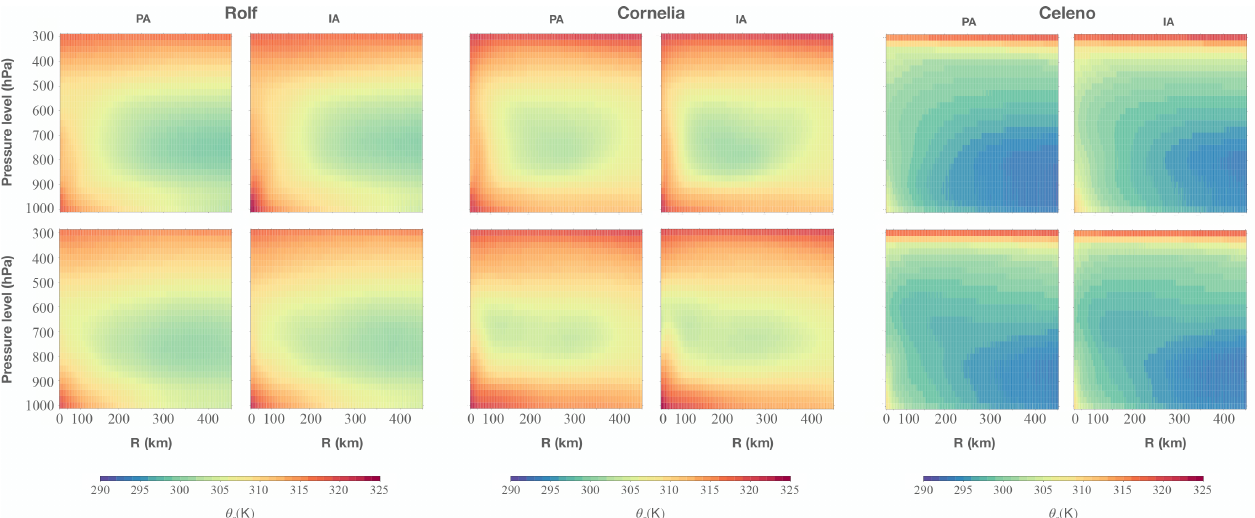
Figure 4. Time-averaged height–radius cross sections of the equivalent potential temperature ( θ e ) over all time steps in which a medicane is found in the NN (top) and SN (bottom) simulations for medicanes Rolf (simulation starting 5 November 2011 at 00:00UTC with 36h of run-up time), Cornelia (simulation starting on 5 October 1996 at 00:00UTC with 36h of run-up time) and Celeno (simulation starting on 13 January 1995 at 00:00UTC with 36h of run-up time).